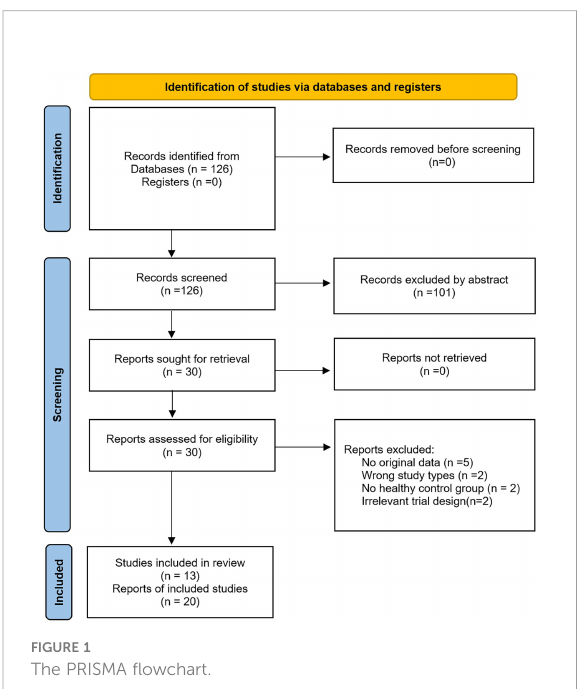
FIGURE 1 The PRISMA fl